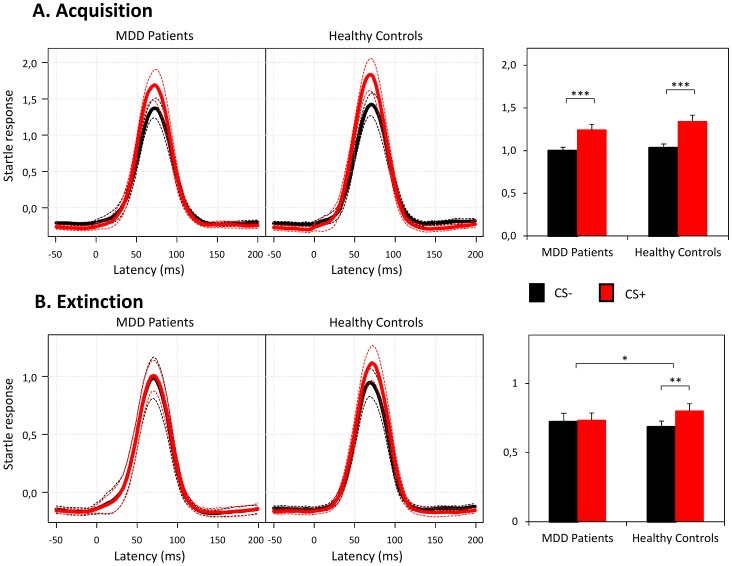
Startle responses to conditioned stimuli.
A. In the acquisition phase, both groups showed successful fear acquisition, as evidenced by significantly stronger responses to the CS+ than to the CS−. B. In the extinction phase, patients with MDD showed significantly stronger extinction learning in comparison to healthy controls, as indicated by the significant interaction between CS type×Group. Particularly, patients with MDD showed robust extinction learning, whereas healthy controls did not. Startle response amplitudes are expressed as a proportion of the mean intertrial interval (ITI) startles during the acquisition phase. Dashed lines represent 95% confidence intervals. Bars represent means ± SEM. Note that the bars represent the mean signal amplitude of the time interval from 40 to 90 ms and not the absolute level, resulting in levels lower than 1. *p<.05, **p<.01, ***p<.001, ANOVA and post-hoc paired-sample t-test.